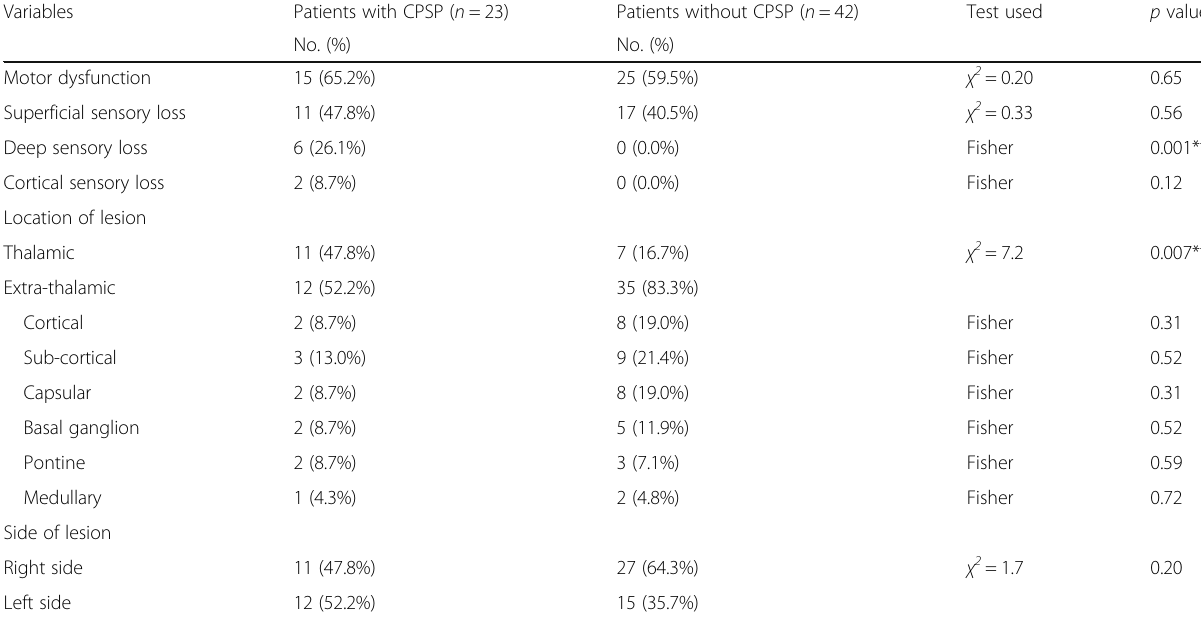
Table 1 Clinical characteristics and location of stroke according to (MRI) Variables Patients with CPSP ( n = 23) Patients without CPSP ( n = 42) Test used p